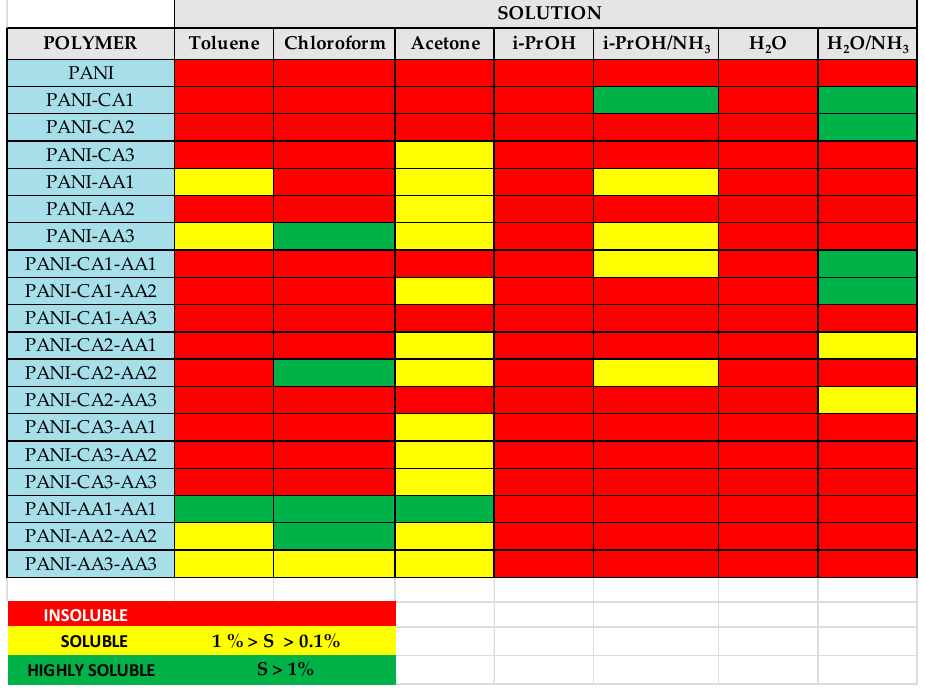
Figure 1. Color coded 2D diagram of the effect of combinatorially added functional group on the solubility in common solvents/solutions.